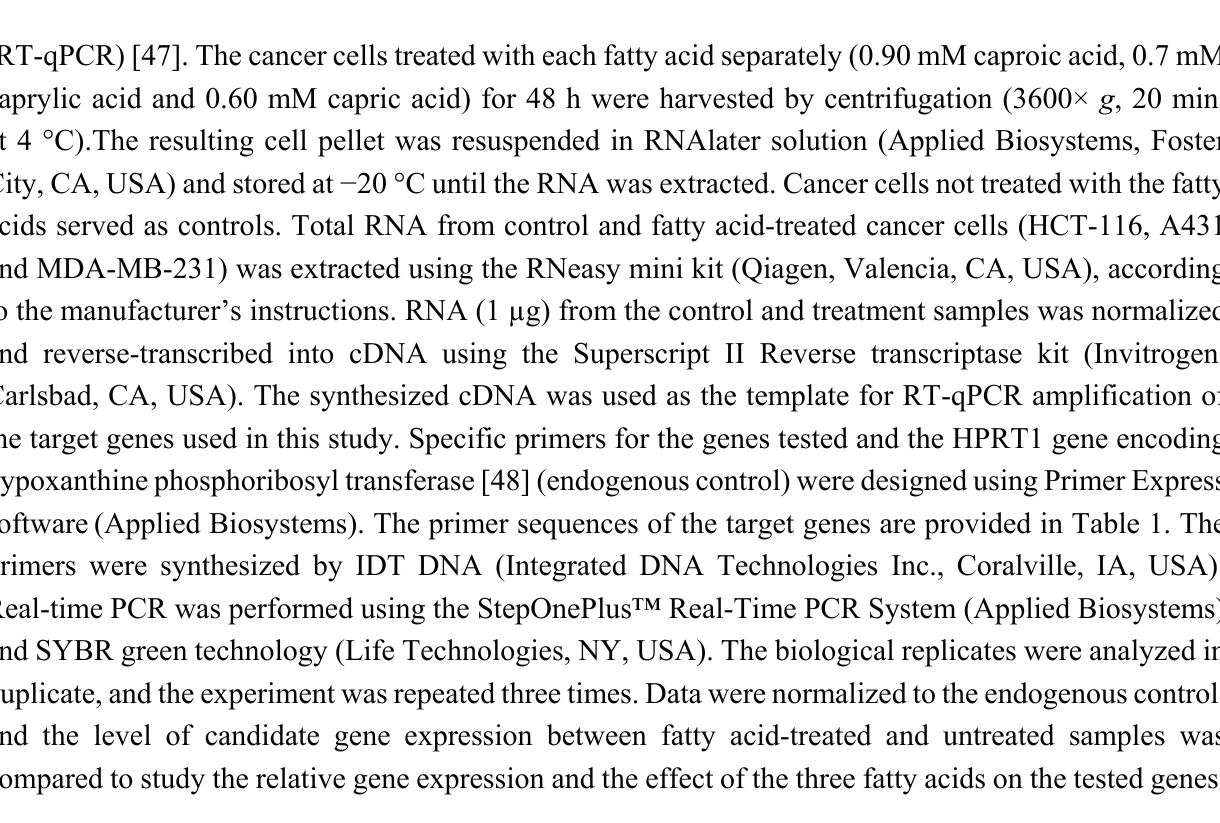
Table 1. Primers used in this study. Primers were designed using Primer Express 3.0 from Applied